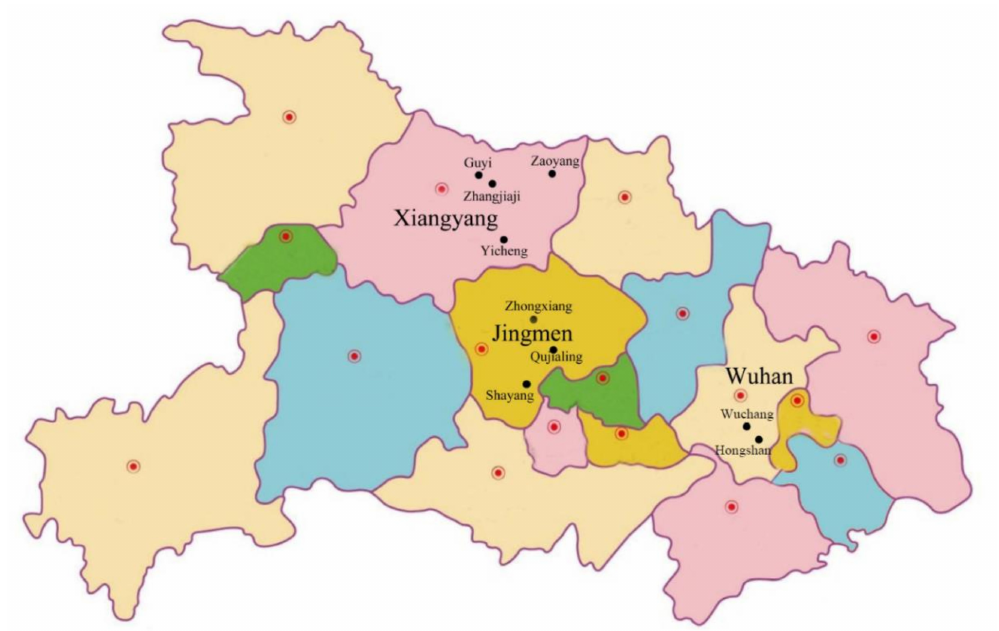
Figure 1. Locations of the experimental sites (black solid dots) that were used to calibrate and validate the agricultural production system simulator (APSIM)-wheat model. Note: The experimental sites